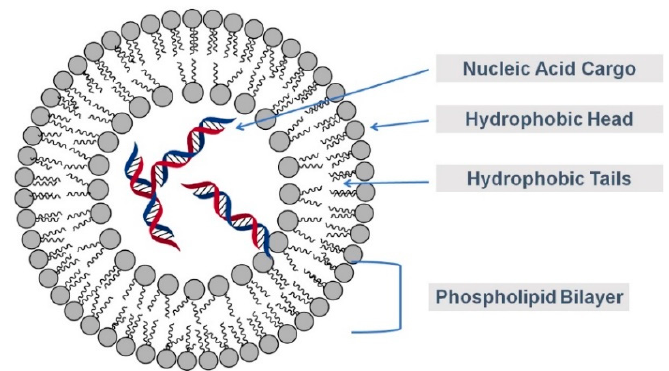
Figure 8. Representation of captured DNA in a liposome. Color image available online.